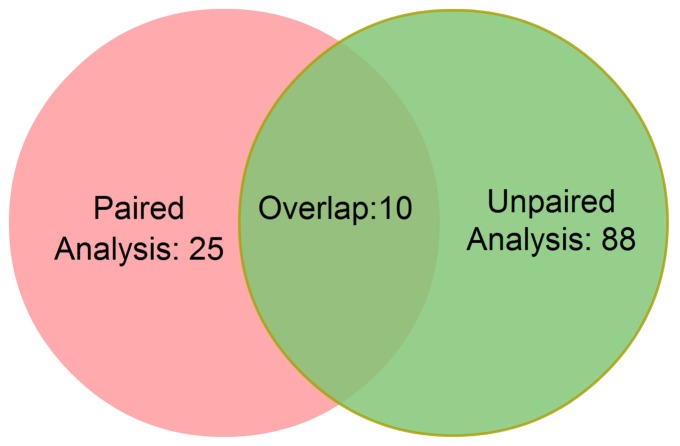
Venn diagram of ANOVA test results from paired and unpaired miRNA expression analysis.ANOVA test on the paired miRNA microarray data analysis resulted in 35 deregulated miRNAs, while ANOVA test on the unpaired analysis showed 98 deregulated miRNAs. There are 10 overlapping miRNAs (miR-1268, mir-130a, miR-141, miR-193b, miR-200b, miR-21, miR-320a, miR-370, miR-557 and kshv-mir-K12-3).